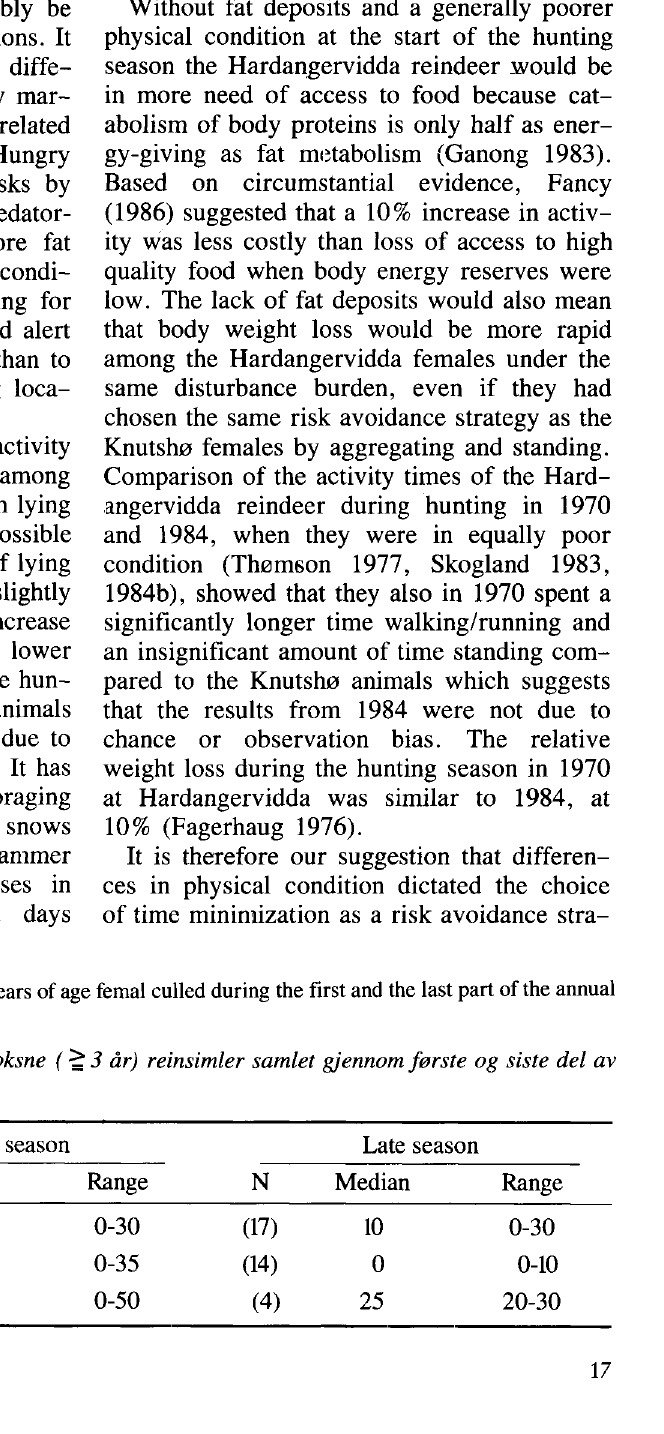
Table 3. Back fat thickness (mm) of adult ^ 3 years of age femal culled during the first and the last part of the annual hunting